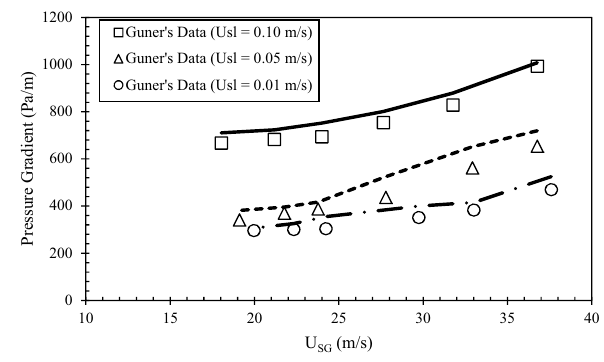
Fig. 2 Validation of the current model against the experimental data of Guner (2012) using pressure gradient measurements (lines are CFD